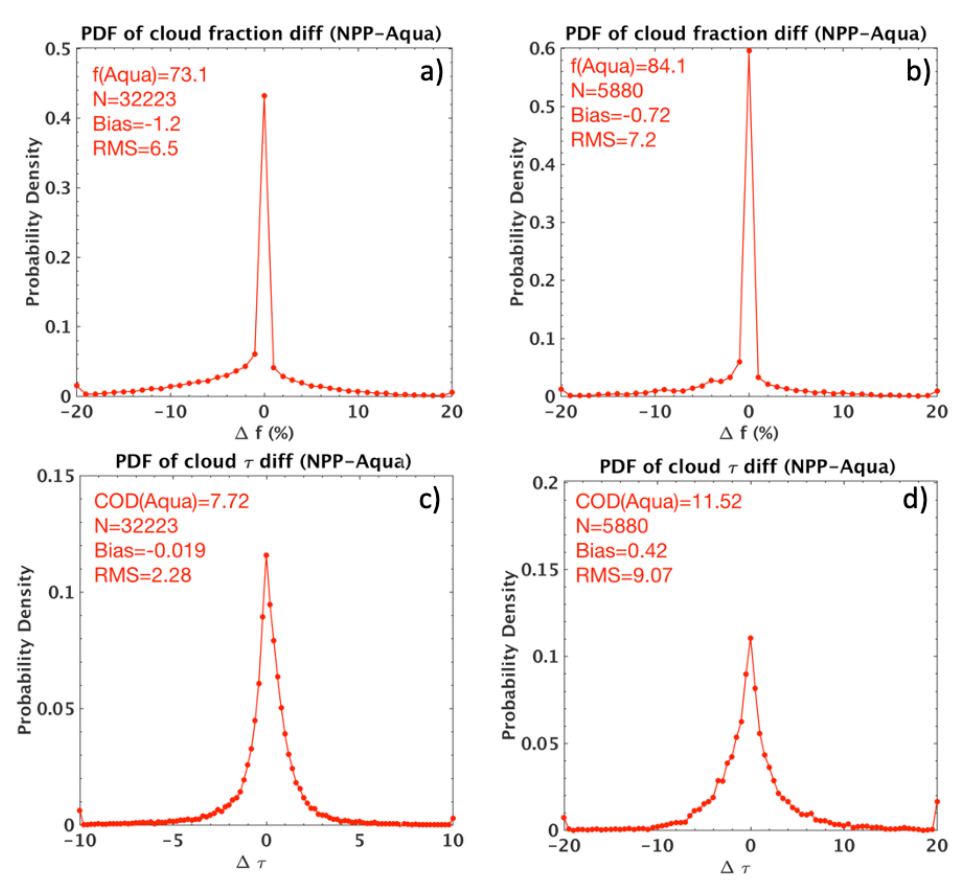
Figure 10. Probability distribution function for the cloud fraction ( f , in%) differences between S-NPP and Aqua for regions between 60 ◦ S–60 ◦ N ( a ) and for regions poleward of 60 ◦ ( b ), and the cloud optical depth ( τ ) differences for regions between 60 ◦ S–60 ◦ N ( c ) and for regions poleward of 60 ◦ ( d